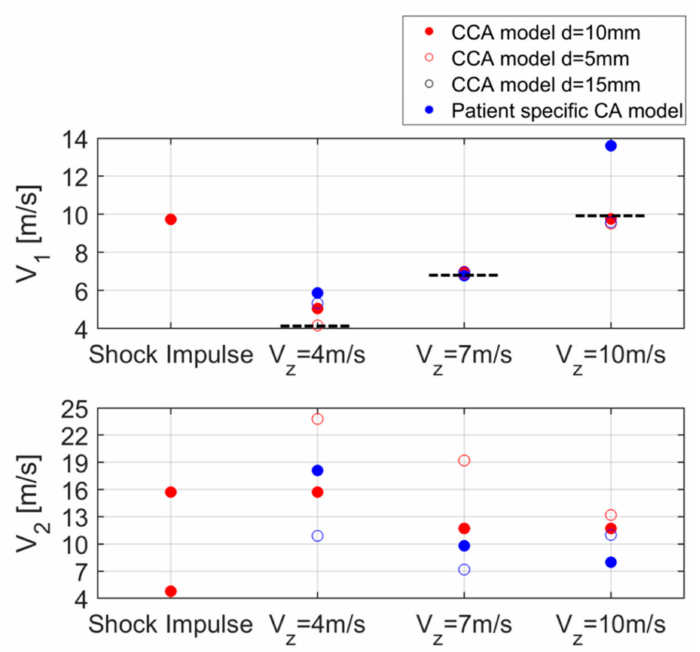
Figure 11. Summary of the estimated V 1 and V 2 values at the skin surface for all the simulations. The dotted line represents the